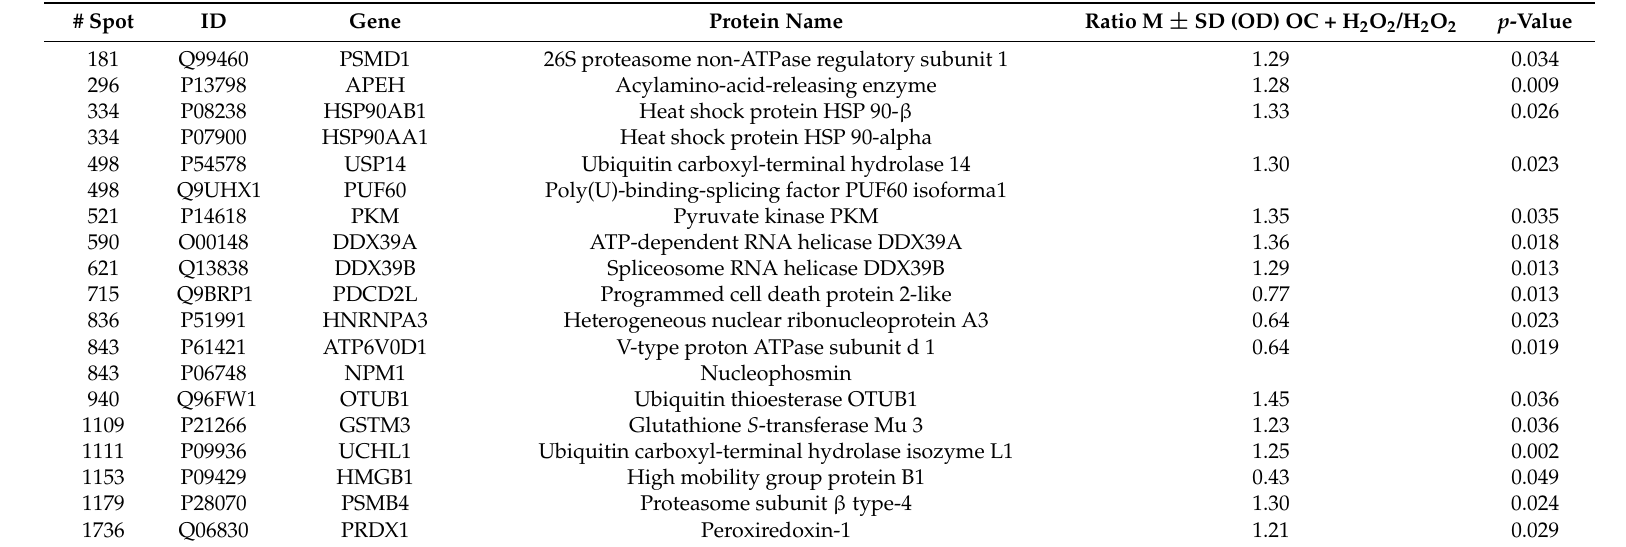
Table 3. List of differentially expressed proteins after comparison between oleocanthal (OC) + H 2 O 2 vs. H 2 O 2 . ID: SwissProt accession. Number; OD: Normalized optical